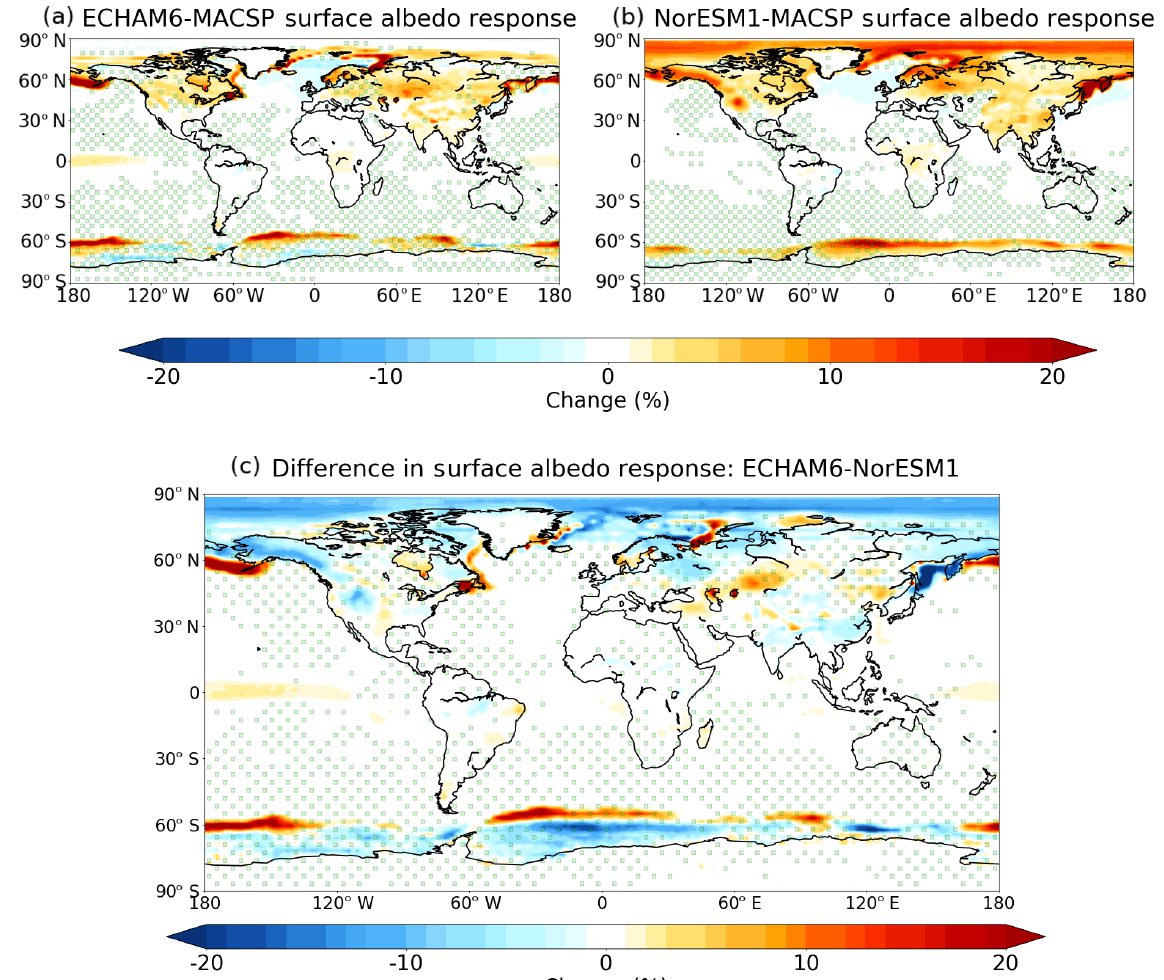
Figure C2. Surface albedo response to the addition of anthro- pogenic aerosols. (a) Response in the ECHAM6-MACSP experi- ment; (b) response in the NorESM1-MACSP experiment; (c) the difference in surface albedo response: ECHAM6-MACSP experi- ment minus NorESM1-MACSP experiment. The green dots repre- sent the area where anthropogenic aerosols do not have a statisti- cally significant impact at the p < 0 . 05 level (in panel c ) or where the difference between the models is not statistically significant (in panels a and b